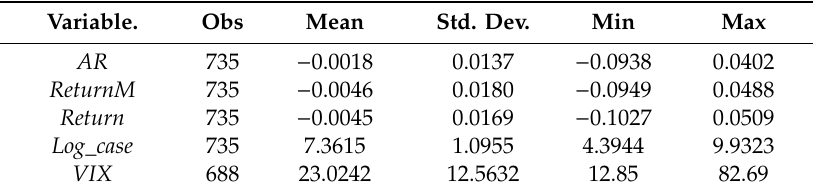
Table 11. Summary